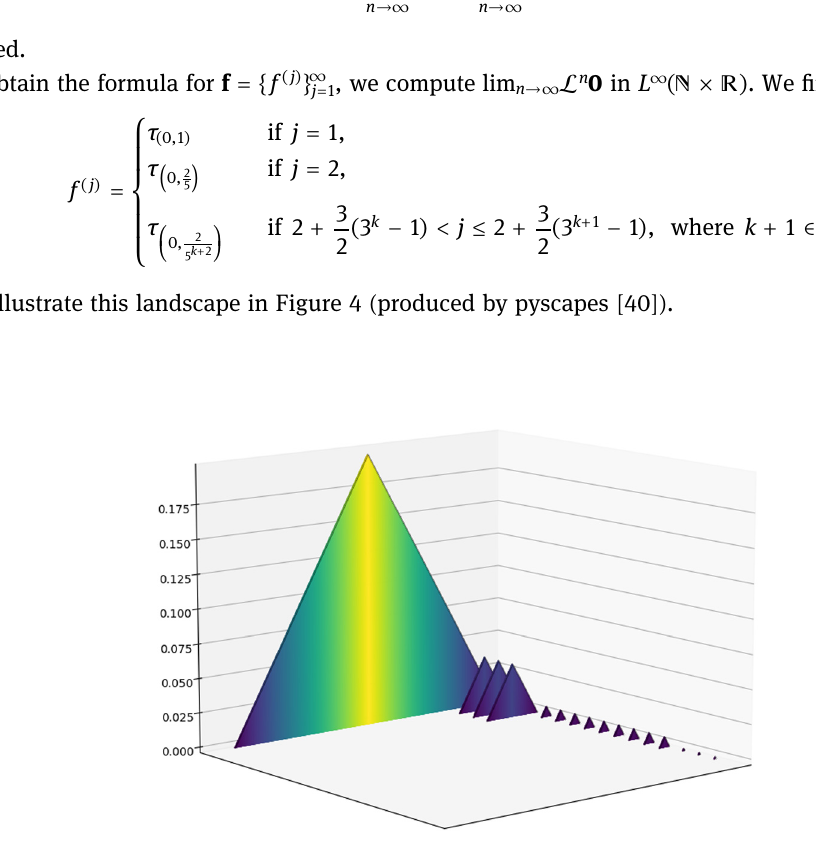
from the persistence landscape of the modi fi ed 1/5 Cantor set (cid:4) Figure 4: Graph of the functions f f ,…, 2 16